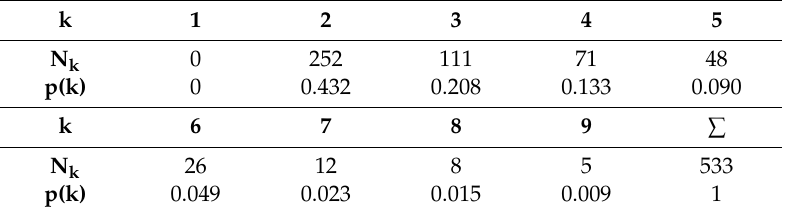
Table 3. Node degree distribution of the Beijing power communication network (2012).